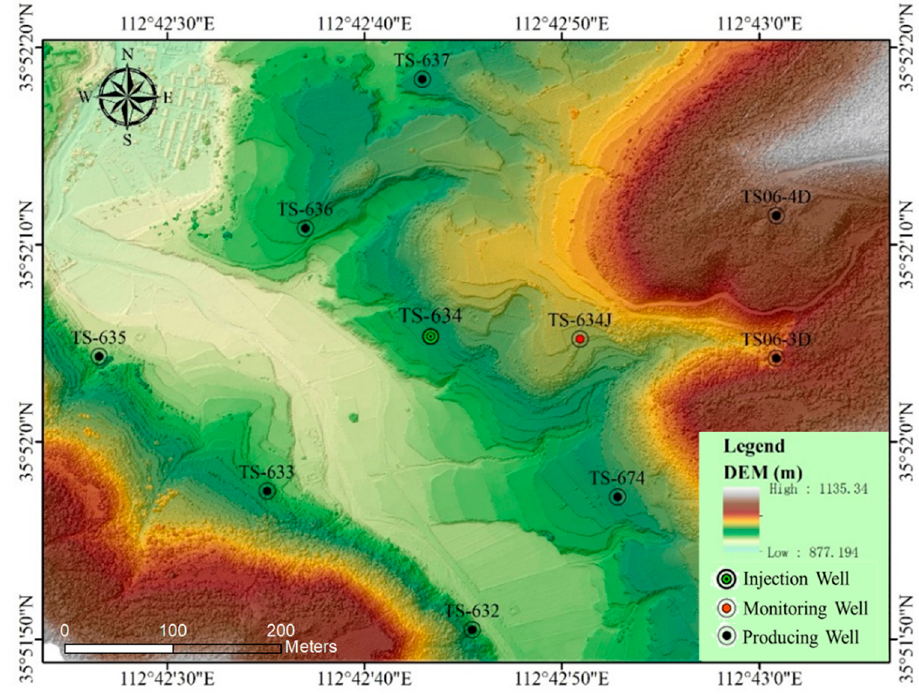
Figure 6. Digital elevation model extract by UAV 3D model of the Shizhuang research area.